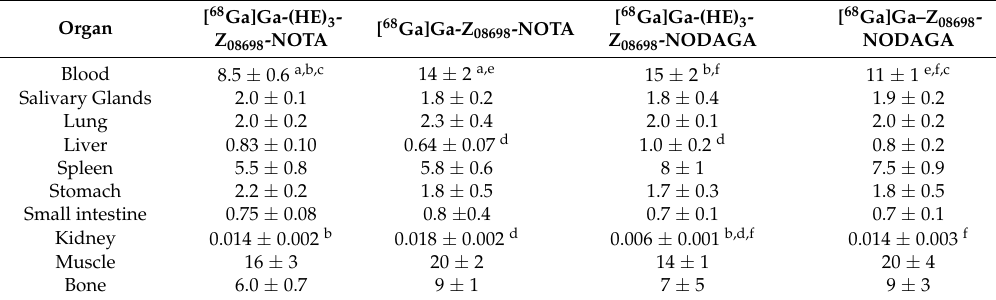
Table 3. Tumor-to-organ ratios 3 h p.i. Female balb/c nu/nu mice with BxPC-3 xenografts were injected with 2 µg of radiolabeled conjugate.